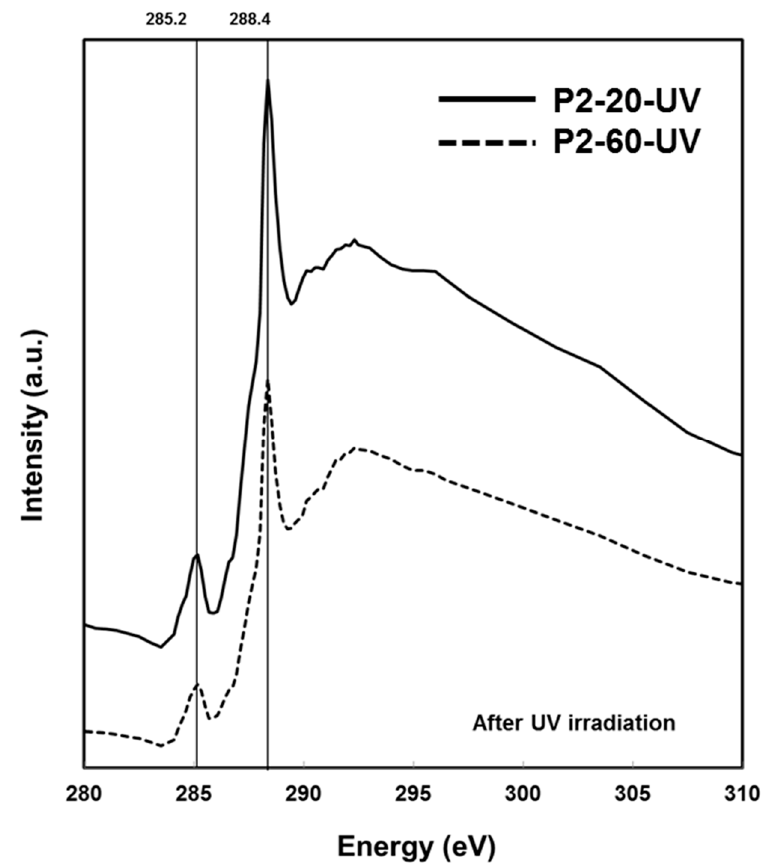
Figure 5. NEXAFS C1s K-edge spectra for P2-20-UV (solid line) and P2-60-UV (dash line) after UV irradiation.